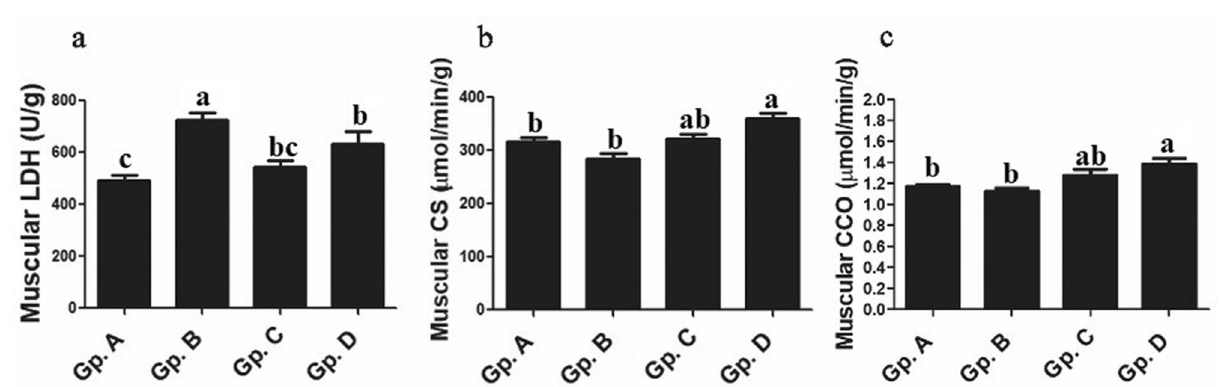
Figure 9. Effect of temperature changes on muscular metabolic enzymes ( a : LDH; b : CS; c : CCO) in Dabb lizard ( U. aegyptia ). Data were expressed as mean ± SE. Gp. A: control group; Gp. B: low temperature exposed group; Gp. C: moderate temperature exposed group; Gp. D: high temperature exposed group; CCO: cytochrome c oxidase; CS: citrate synthase; LDH: lactate dehydrogenase. abc Means above each bar with different letters in different Dabb groups i.e. Gp. A, Gp. B, Gp. C and Gp. D, were significantly different ( P <